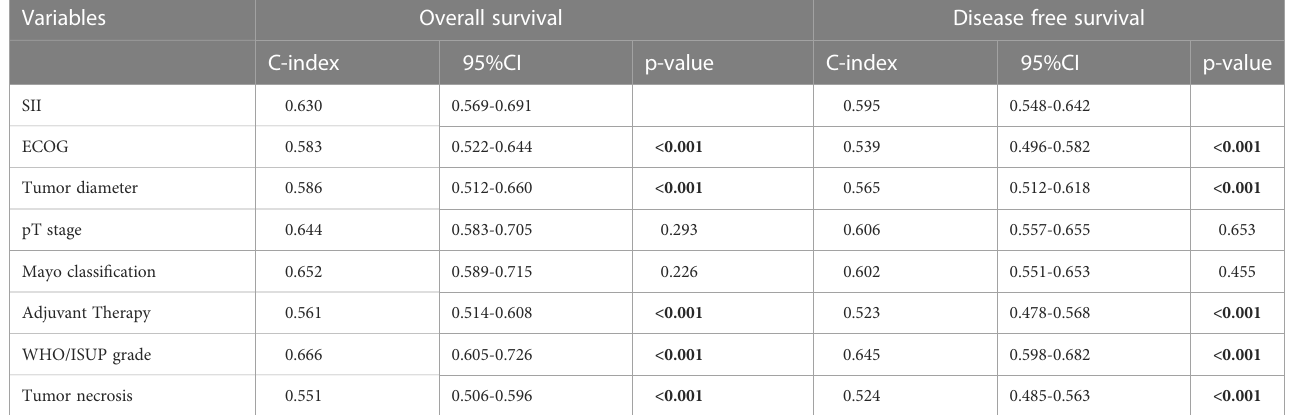
TABLE 4 Concordance index analysis of the prognostic accuracy of potential